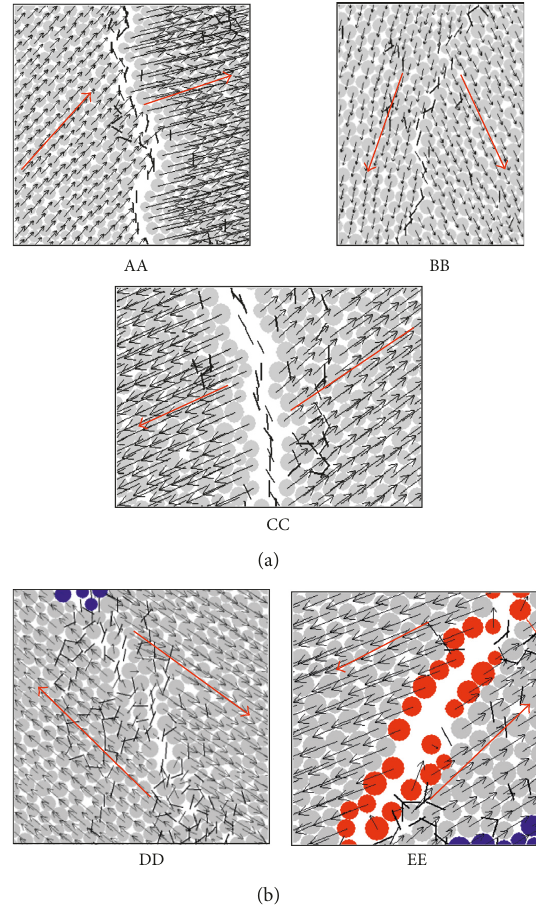
Figure 8: Mesodisplacement field distribution of (a) macrotensile crack and (b) macroshear